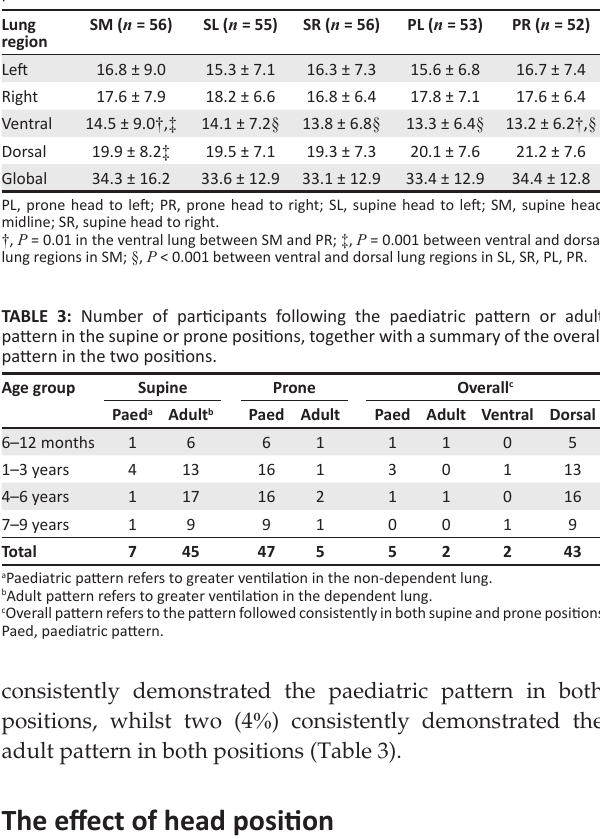
TABLE 1: Sample characteristics. Age group